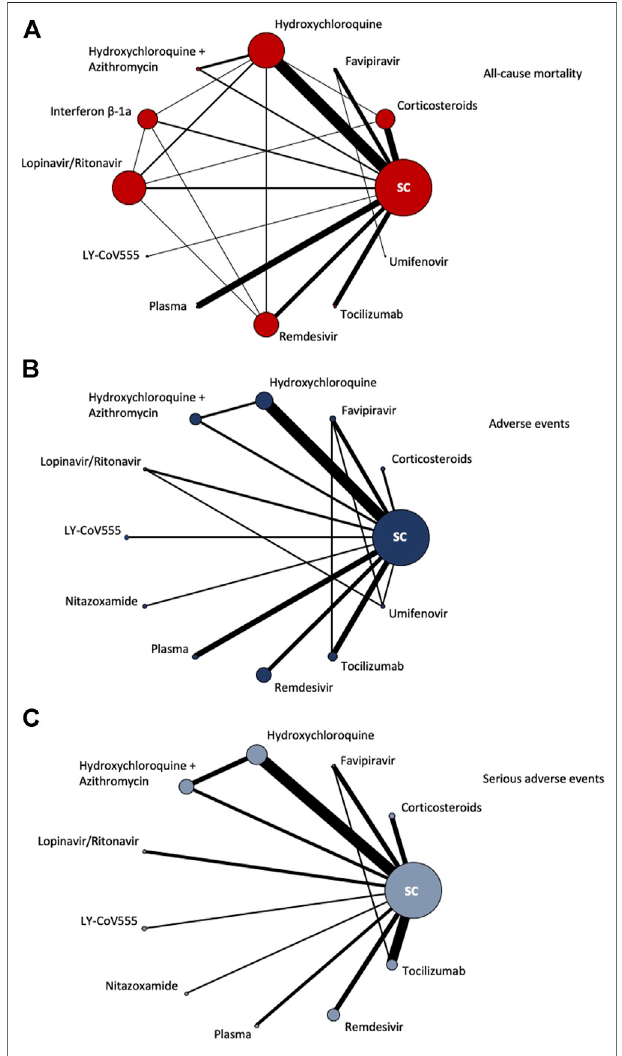
FIGURE 2 | Network of eligible comparisons for all-cause mortality, adverse events and serious adverse events. The fi gure plots the network of eligible direct comparisons for all-cause mortality (42 studies) (A) , adverse events (30 studies) (B) and serious adverse events (30 studies) (C) . The widthofthelinesisproportionaltothenumberoftrialscomparingeverypairof treatments, and the size of every node is proportional to the number of randomized